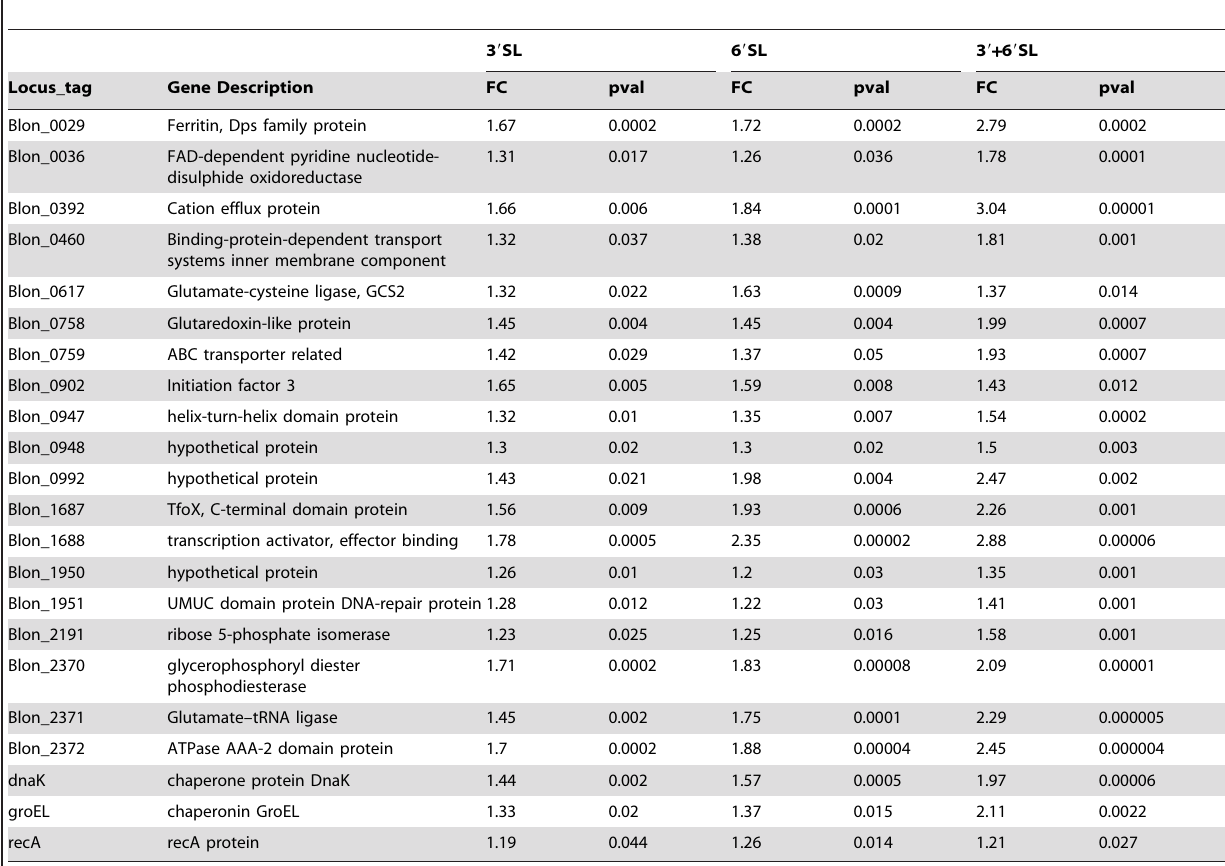
Table 2. Up-regulated genes common to all three oligosaccharide treatments.